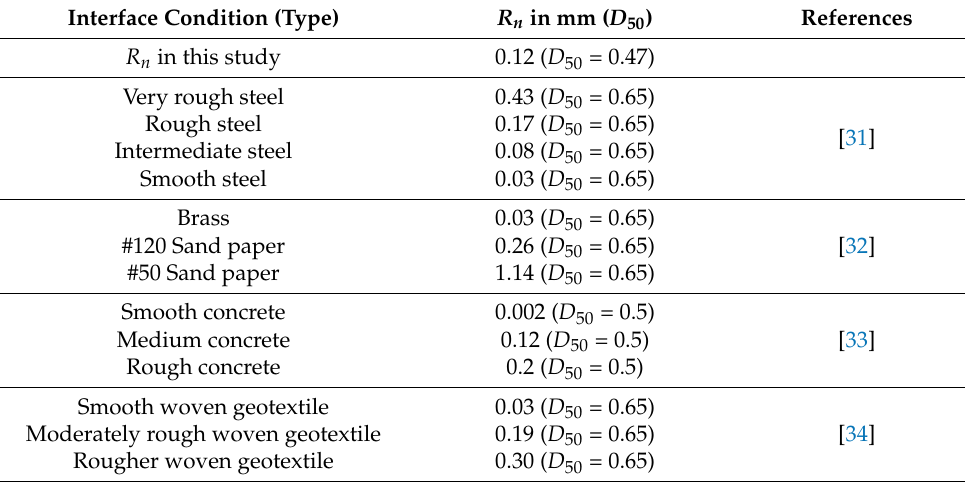
Table 2. Normalized relative roughness ( R n ) used in this